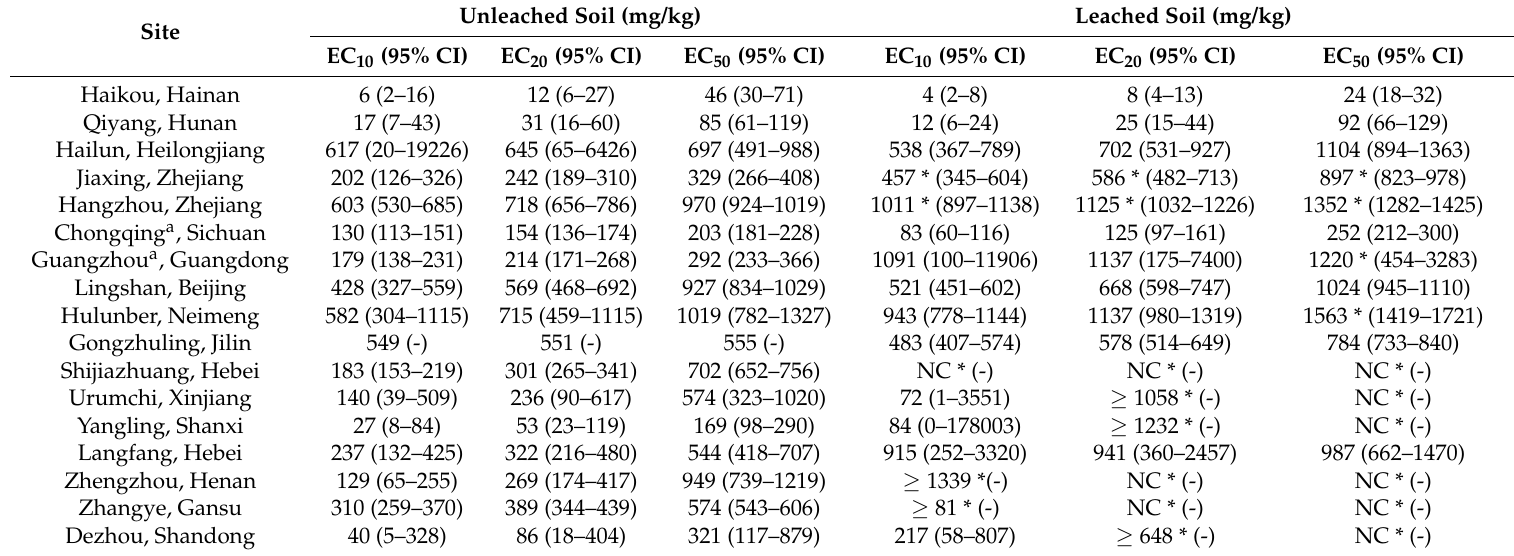
Table 3. Toxicity thresholds based on the Ni concentrations of three EDTA extractions and barley root elongation in unleached and leached